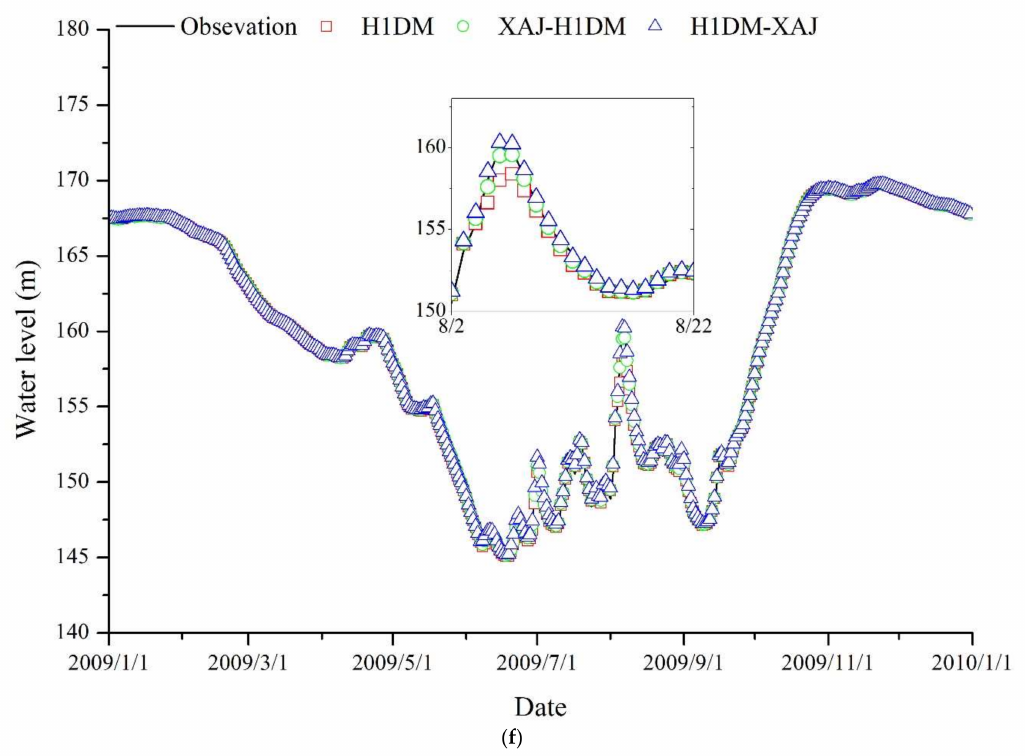
Figure 7. Streamflow hydrographs for several sites. ( a ) CT-2009-Flow; ( b ) CT-2009-Water level; ( c ) QXC-2007-Flow; ( d ) QXC-2007-Water level; ( e ) QXC-2009-Flow; ( f ) QXC-2009-Water level.